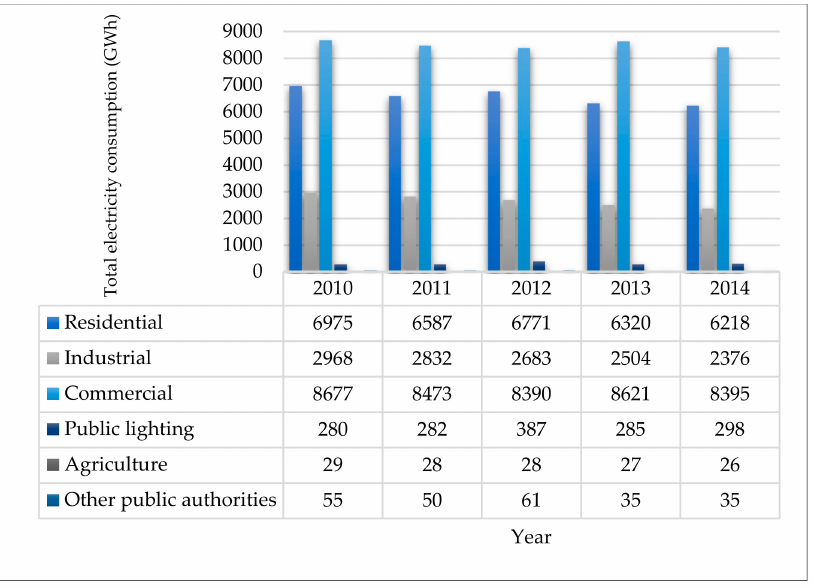
Figure 5. Historical PREPA electricity consumption (from 2010 to 2014) by customer classes.